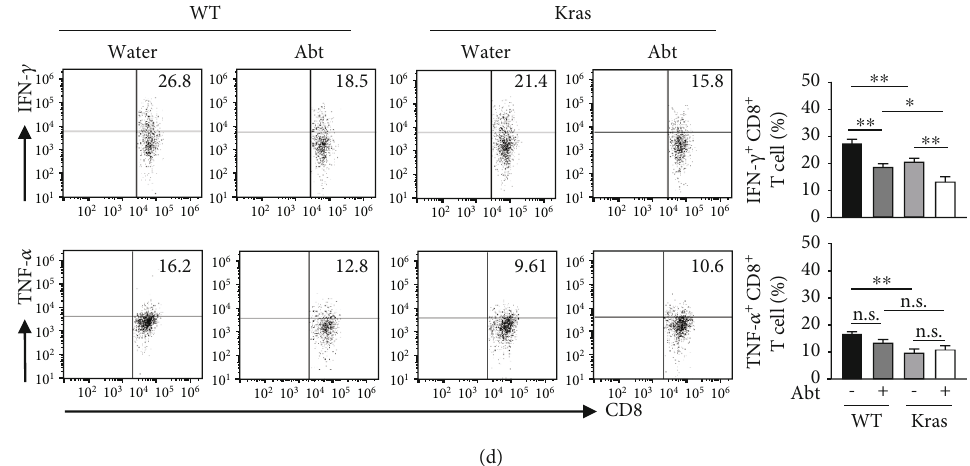
Figure 3: Production of IFN- γ was impaired in NK cells and CD8 + T cells at stage 3 of lung cancer in Abt- Kras mice. (a and b) Representative dot plots and quanti fi cations of IFN- γ and TNF- α expression in lung NK cells (a) and CD8 + T cells (b) at stage 1 cancer. (c and d) Representative dot plots and quanti fi cations of IFN- γ and TNF- α expression in lung NK cells (c) and CD8 + T cells (d) at stage 3 cancer, n = 4 − 6 . Data are presented as mean ± SEM . ∗ p < 0 : 05 , ∗∗ p < 0 : 01 , and ∗∗∗ p < 0 : 001 . n.s.: not signi fi